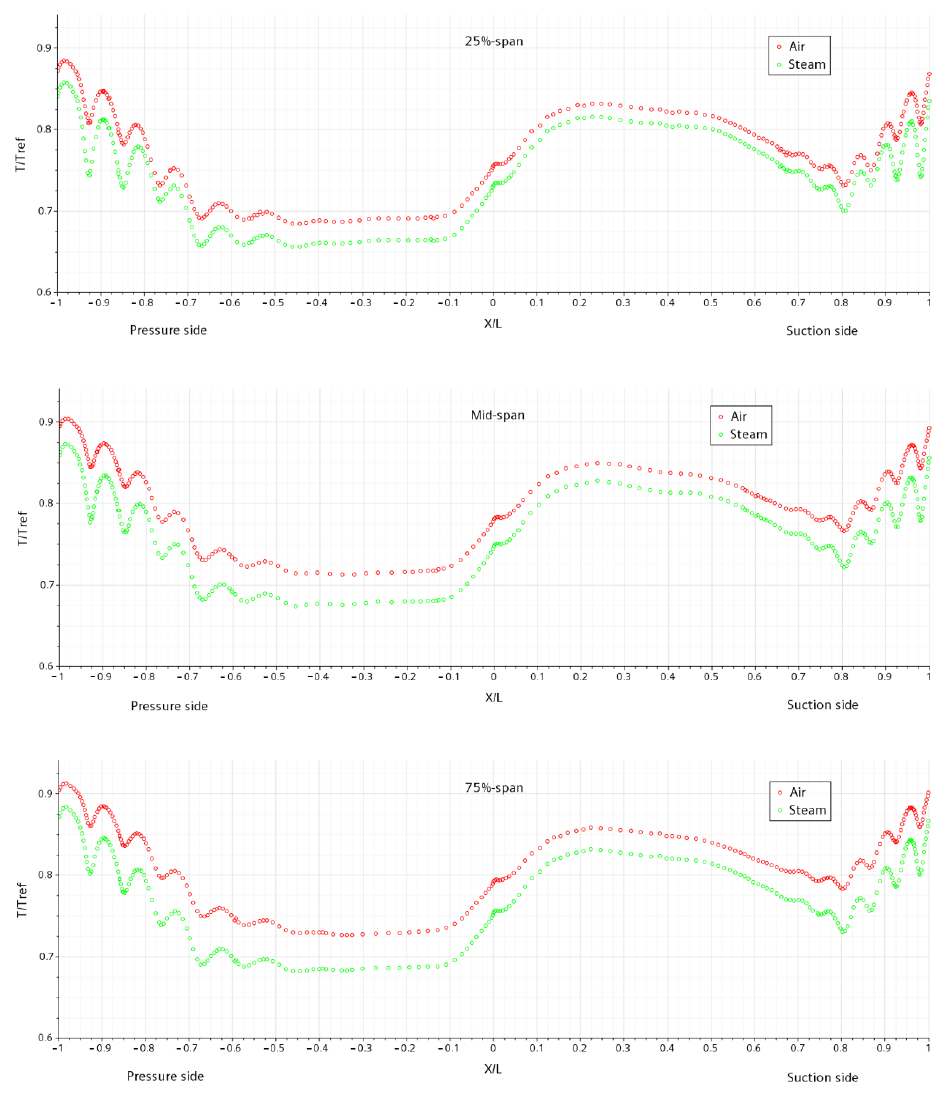
Figure 9. Comparison of normalised temperature distribution at the three cross-sectional planes. The reference temperature is 811 K, as reported in